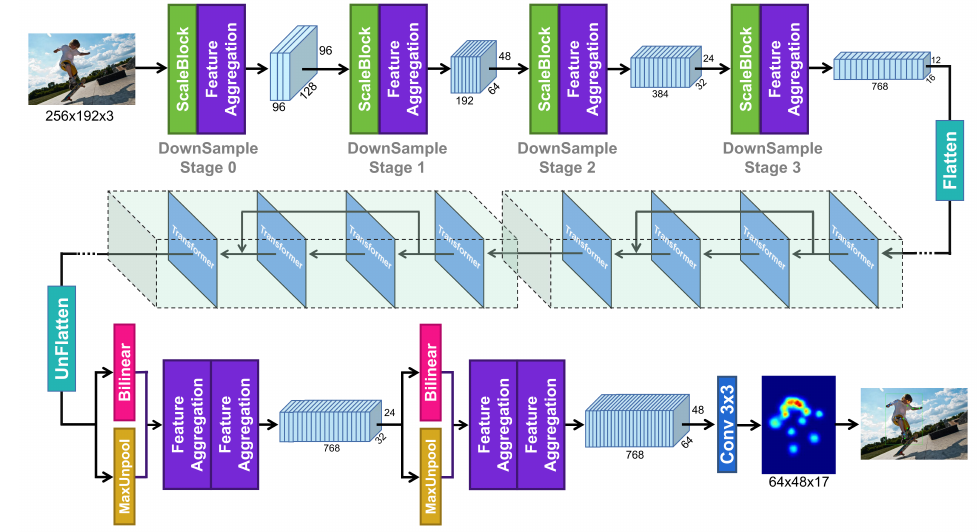
Figure 1. The architectural overview of the